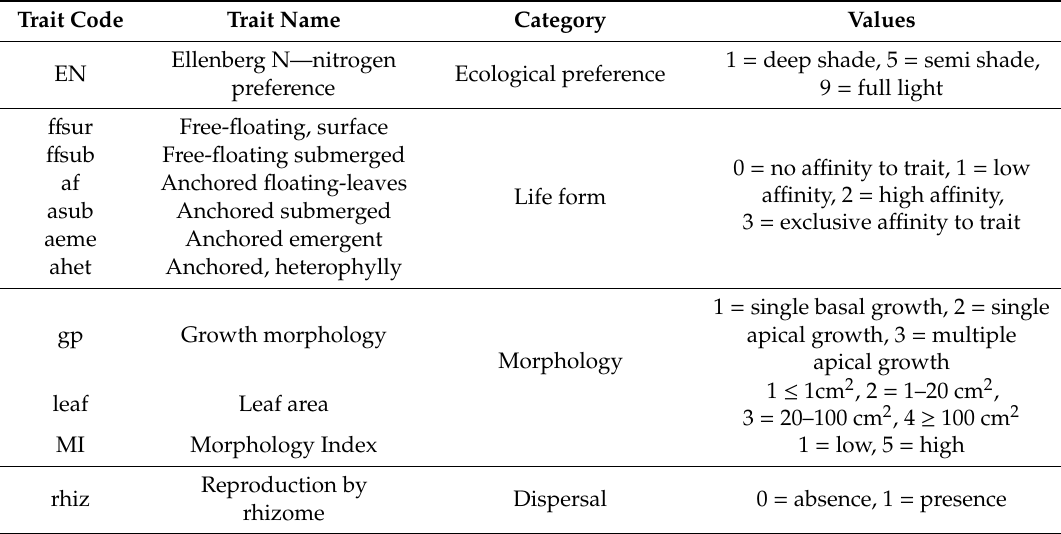
Table 3. Overview of the aquatic macrophyte traits used in the present